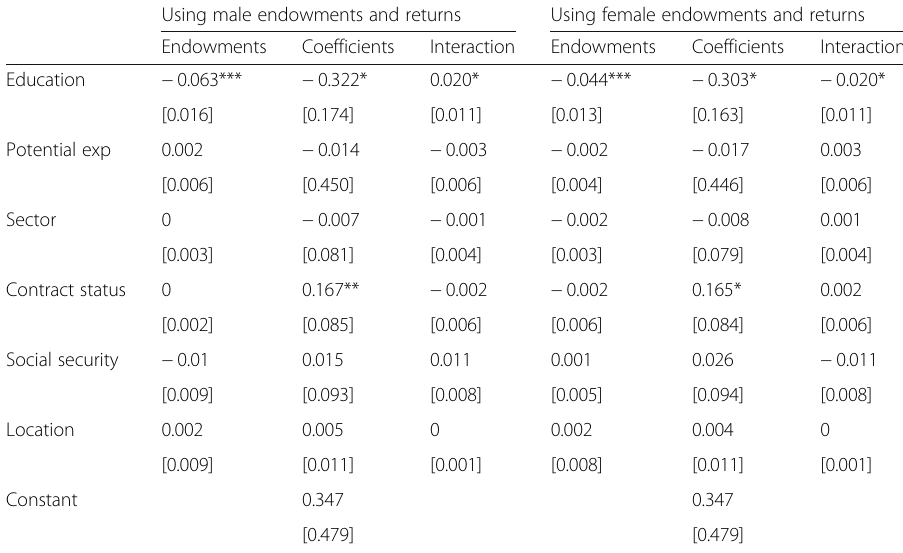
Table 17 Detailed threefold income decompositions: Serbia Using male endowments and returns Using female endowments and returns